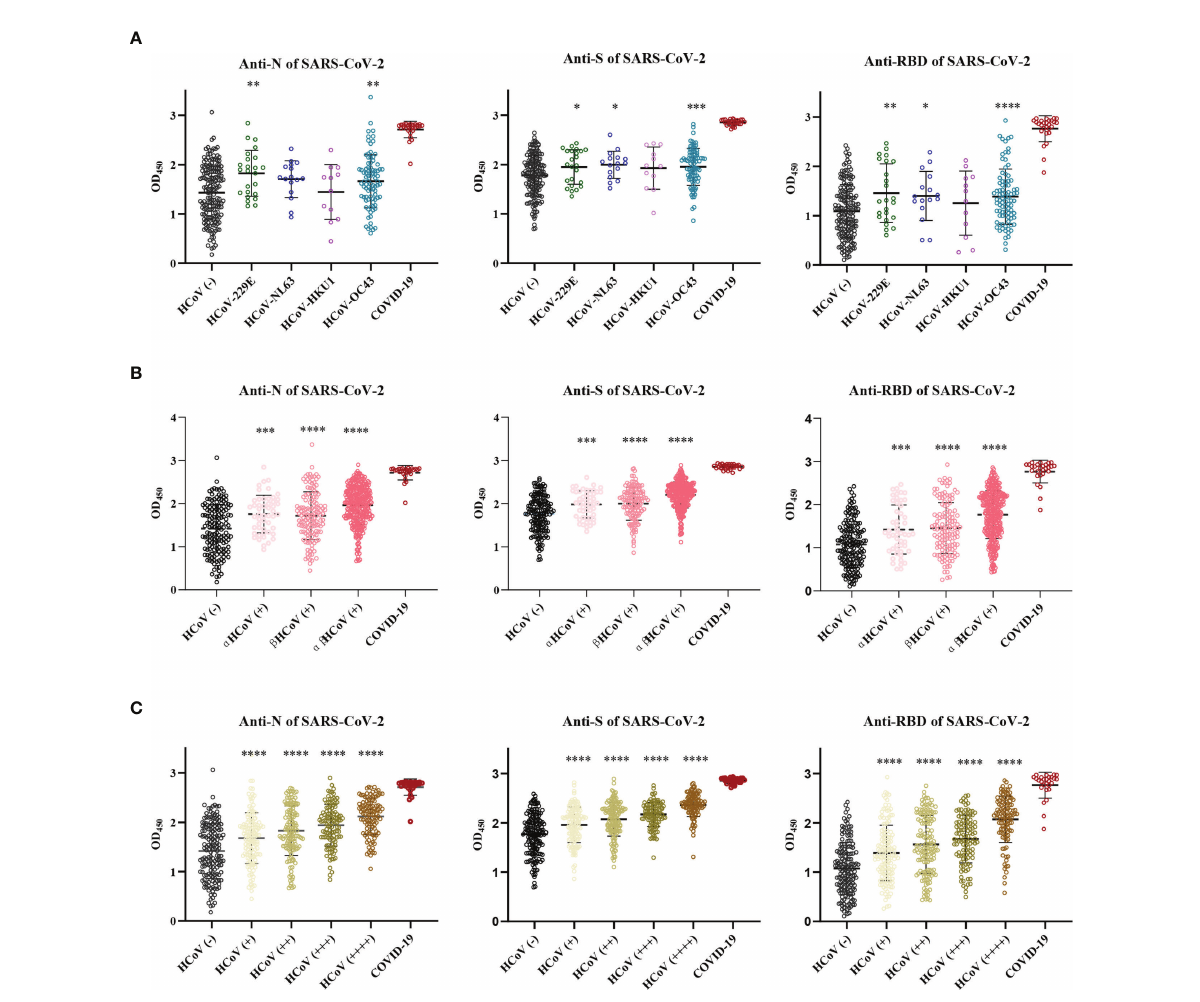
FIGURE 4 The pre-existing antibodies against LPH-CoVs contained cross-reactive antibodies against SARS-CoV-2 (A-C) The cross-reactive IgG antibodies against the N, S, and RBD proteins of SARS-CoV-2 in individuals with exposure to only one of the four LPH-CoVs, (n=298) (A) or re-exposed with different LPH-CoVs (n=658) (B, C) . The individuals with positive values were determined by an OD value greater than the mean OD values of COVID-19 patients minus two times the standard deviation of COVID-19 patients. A two-tailed P value<0.05 was considered statistically signi fi cant, (* P values of ≤ 0.05, ** P values of ≤ 0.01, *** P values of ≤ 0.001, **** P ≤